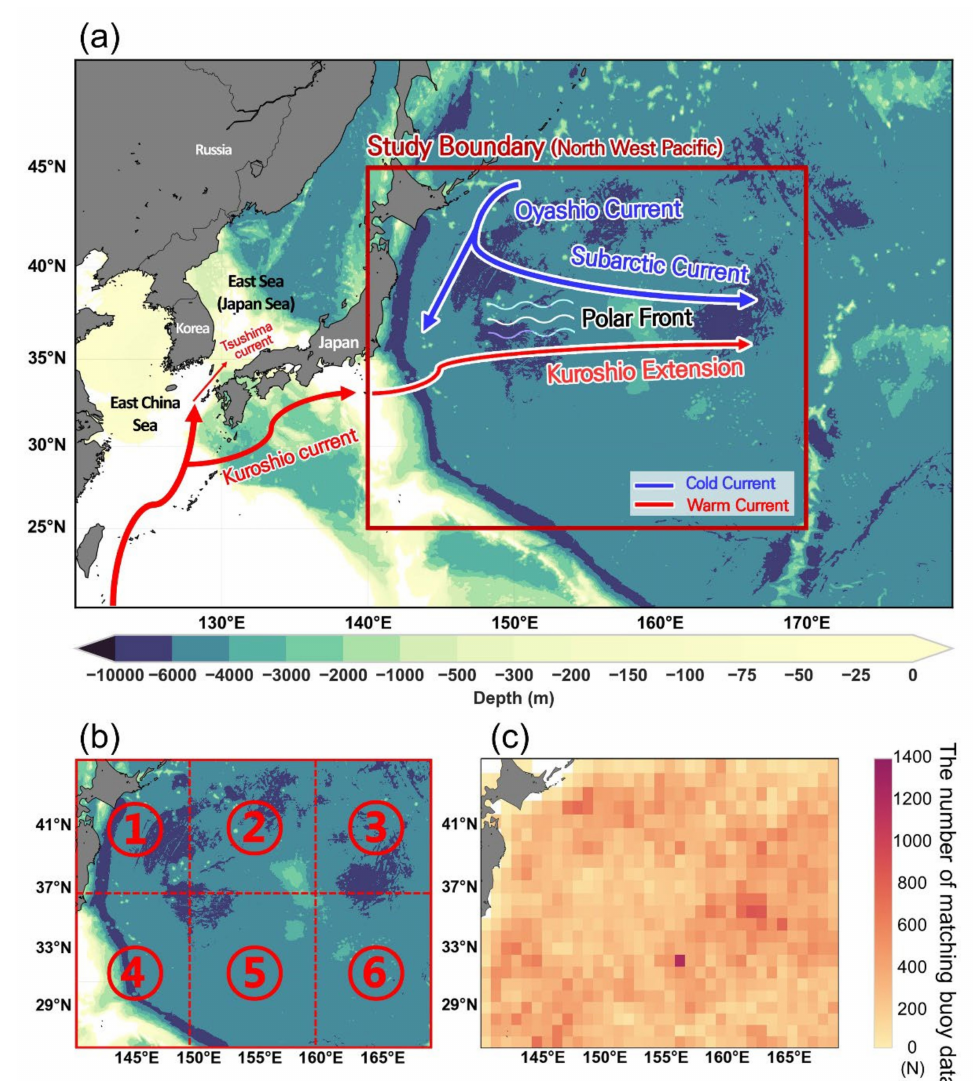
Figure 1. ( a ) The study area in the red rectangle box with surrounding currents. ( b ) Six tiles of the study area. All rectangle tiles are equally divided on the latitude and longitude. ( c ) Accumulated acquisition frequency of drifting buoy data for five years, which are aggregated by 1 ◦ grid for the study area. The bathymetry map was adopted from General Bathymetric Chart of the Oceans (GEBCO) at www.gebco.net, accessed on 27 December